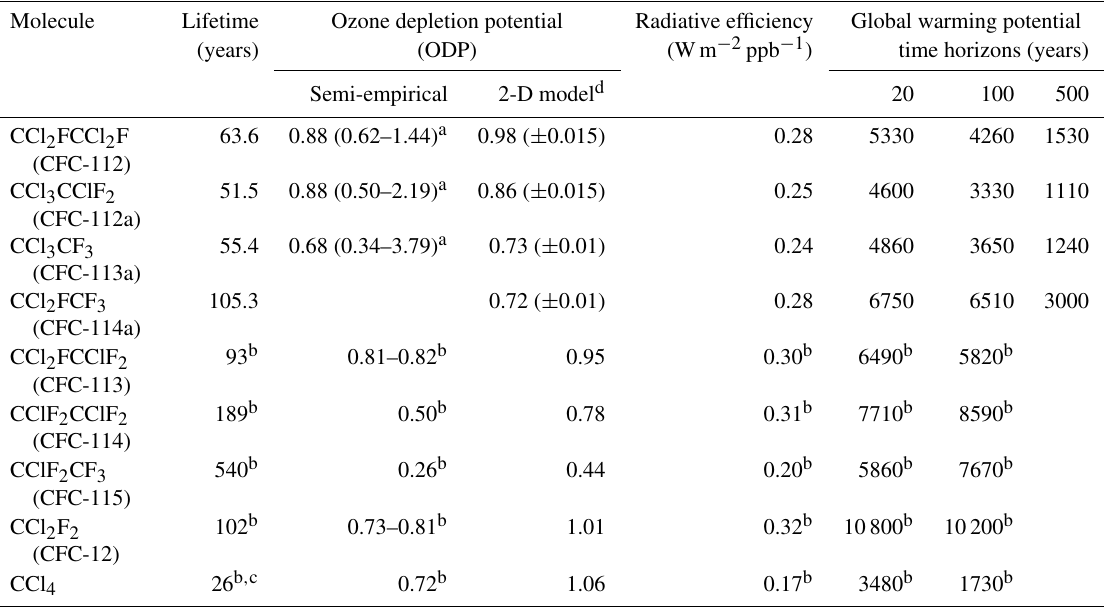
Figure 5. Global annually averaged vertical profiles of the atmospheric loss processes, molecular loss rates, and mixing ratio for CCl 2 FCCl 2 F (CFC-112) calculated using the GSFC 2-D atmospheric model for year 2010. The model calculations were performed using the CFC-112 UV absorption spectrum from this work and other model input parameters taken from the literature as described in the text. The global annually averaged lifetime for CFC-112 was calculated to be 63.6 (61.9–64.7) years. Table 6. Lifetimes, ozone depletion potentials (ODPs), radiative efficiencies (REs), and global warming potentials (GWPs) obtained in this work and literature values for